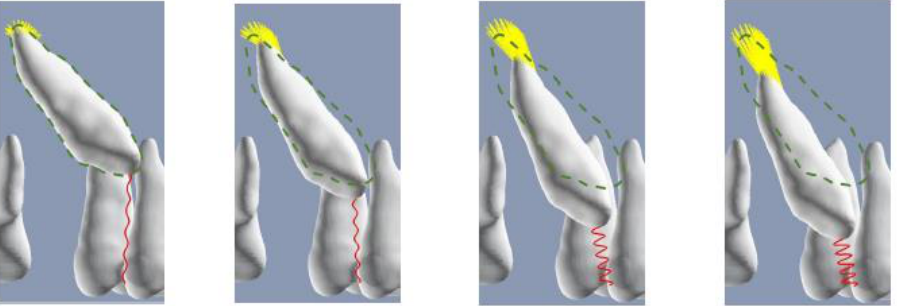
Figure 3. Spring model for instantaneous tooth movement under an external force (red). For display purposes, the PDL length is exaggerated, and only a fraction of the ligament is shown (yellow). The start position of the tooth is overlayed (green).